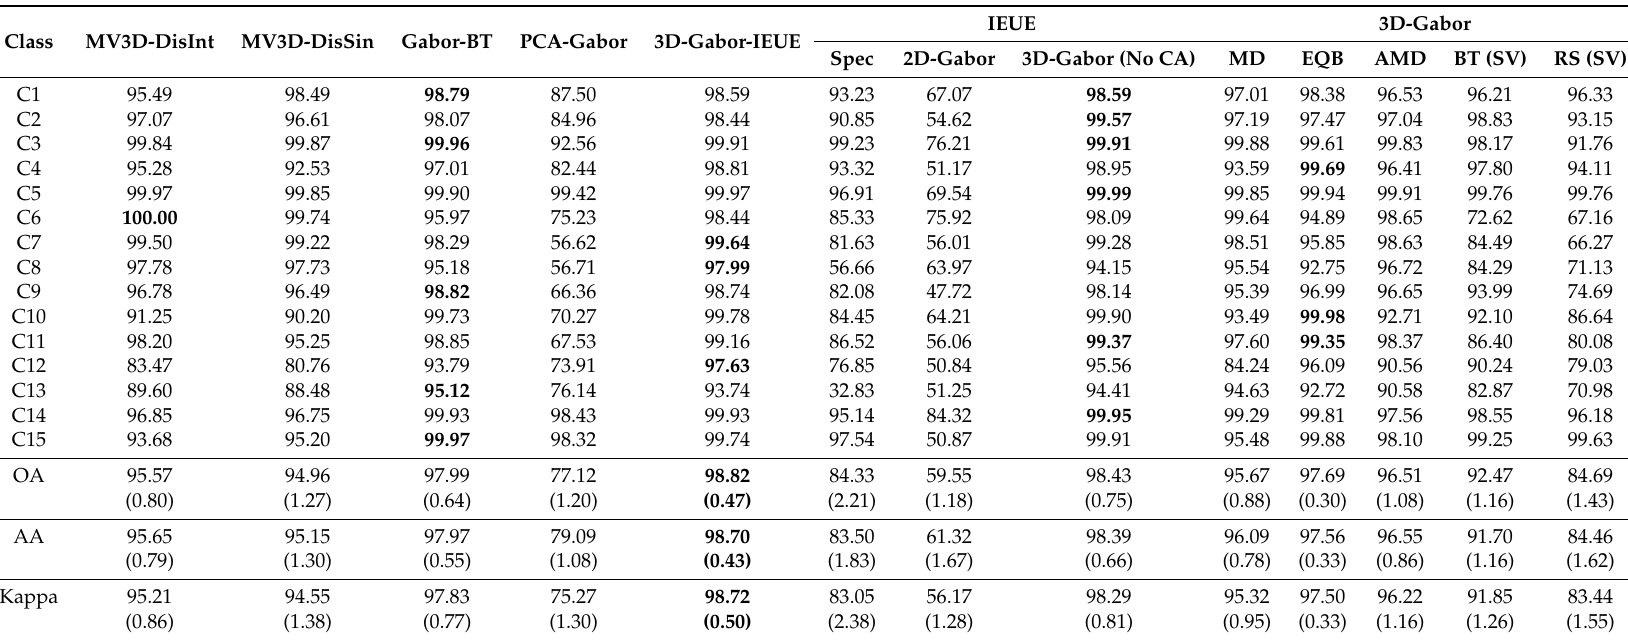
Table 6. Classification accuracies [ % ] of different view generation and sampling selection methods for the University of Houston dataset, using 75 initial training samples (5 per class) and 180 selected samples. For PCA-Gabor, 255 samples (17 per class) are used for training. The numbers in parenthesis are standard deviations. Bold values indicate the best result for a